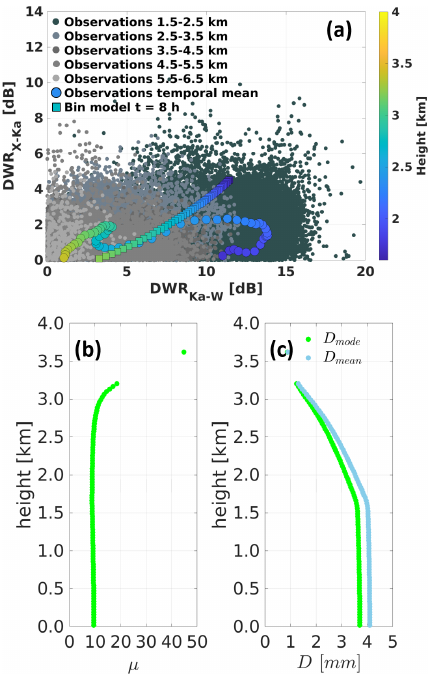
Figure 14. (a) DWR parameter space scatter plot showing the observations (09:30–09:55UTC) at different height ranges, the temporal mean observations (color scale denotes height), and the bin model output at the end of the simulation (8h) (see legend). (b) Shape parameter ( µ ) derived from gamma distribution fits for the rimed ice group at different heights. µ values are only shown for fits in which the adjusted r 2 is larger than 0.98. (c) Mode and mean diameter of the rimed ice group using the gamma fit parame- ters under the same adjusted r 2